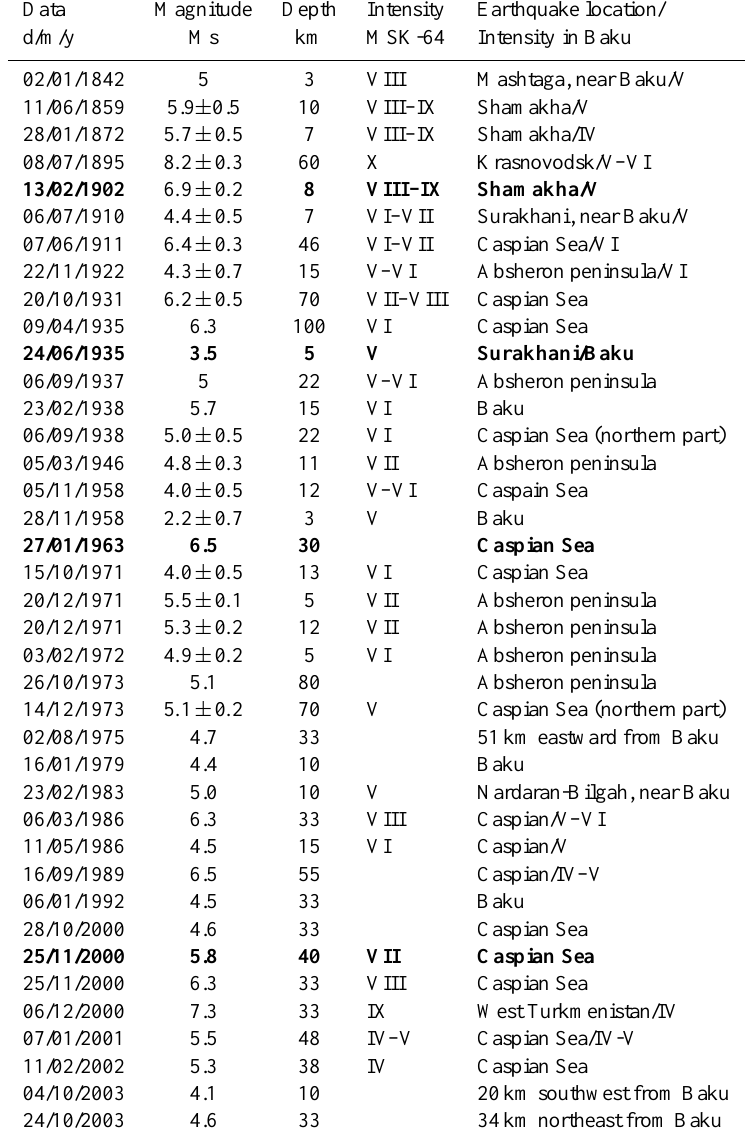
Table 1. Local earthquakes and strong events felt in